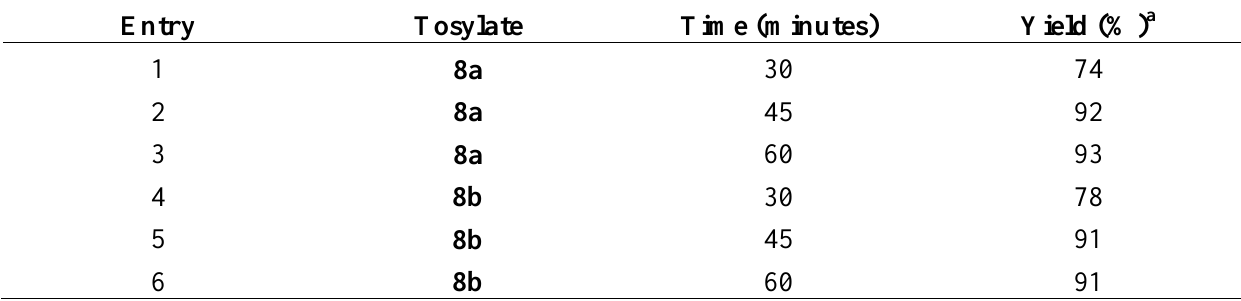
Table 2 : Preparation of the tosylates 8a and 8b under ultrasound